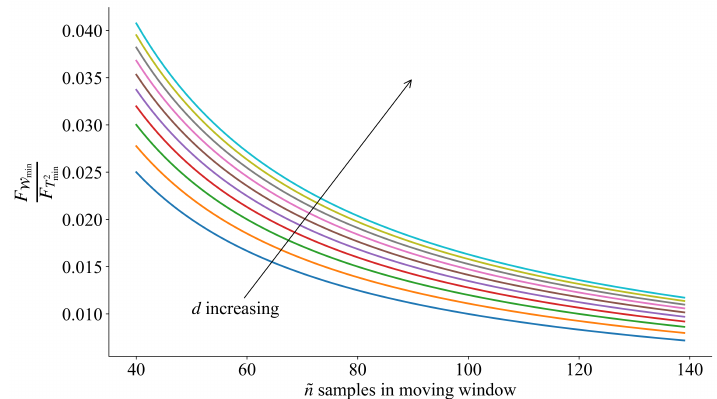
Figure 1. Sensitivity